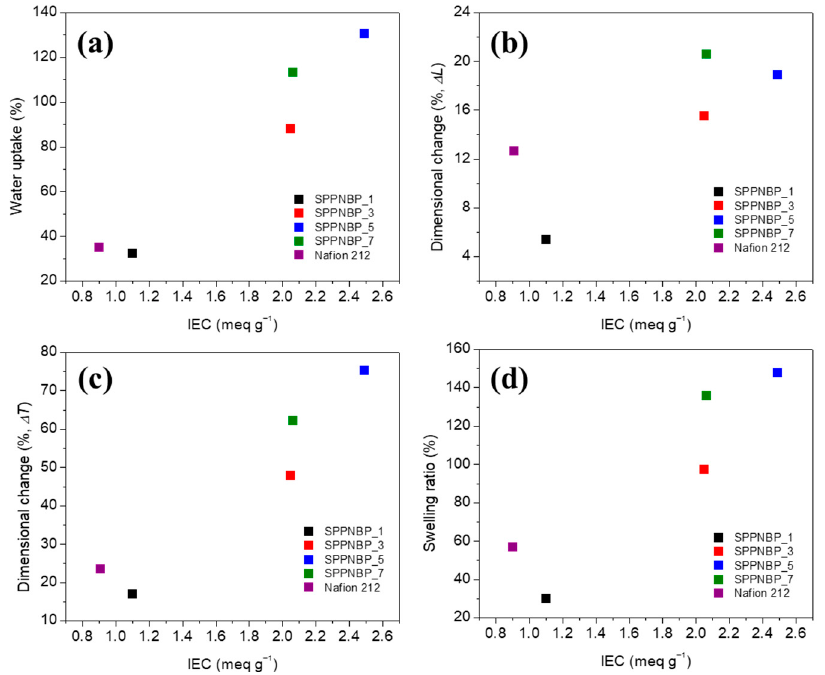
Figure 2. ( a ) Water uptake, dimensional changes of ( b ) in-plane ( Δ L ), and ( c ) through-plane ( Δ T ) directions, and ( d ) swelling ratio of SPPNBP membranes at 80 °C.